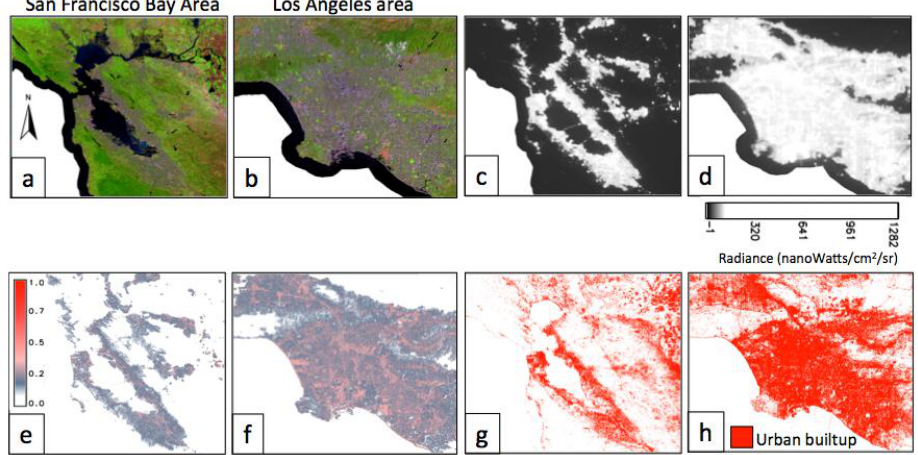
Figure 9. The urban built-up areas extracted from substrate fractional map and NPP-VIIRS data of the SF Bay Area and LA area. Note: ( a , b ) are Landsat RGB composite (bands 3‒5); ( c , d ) are NPP-VIIRS